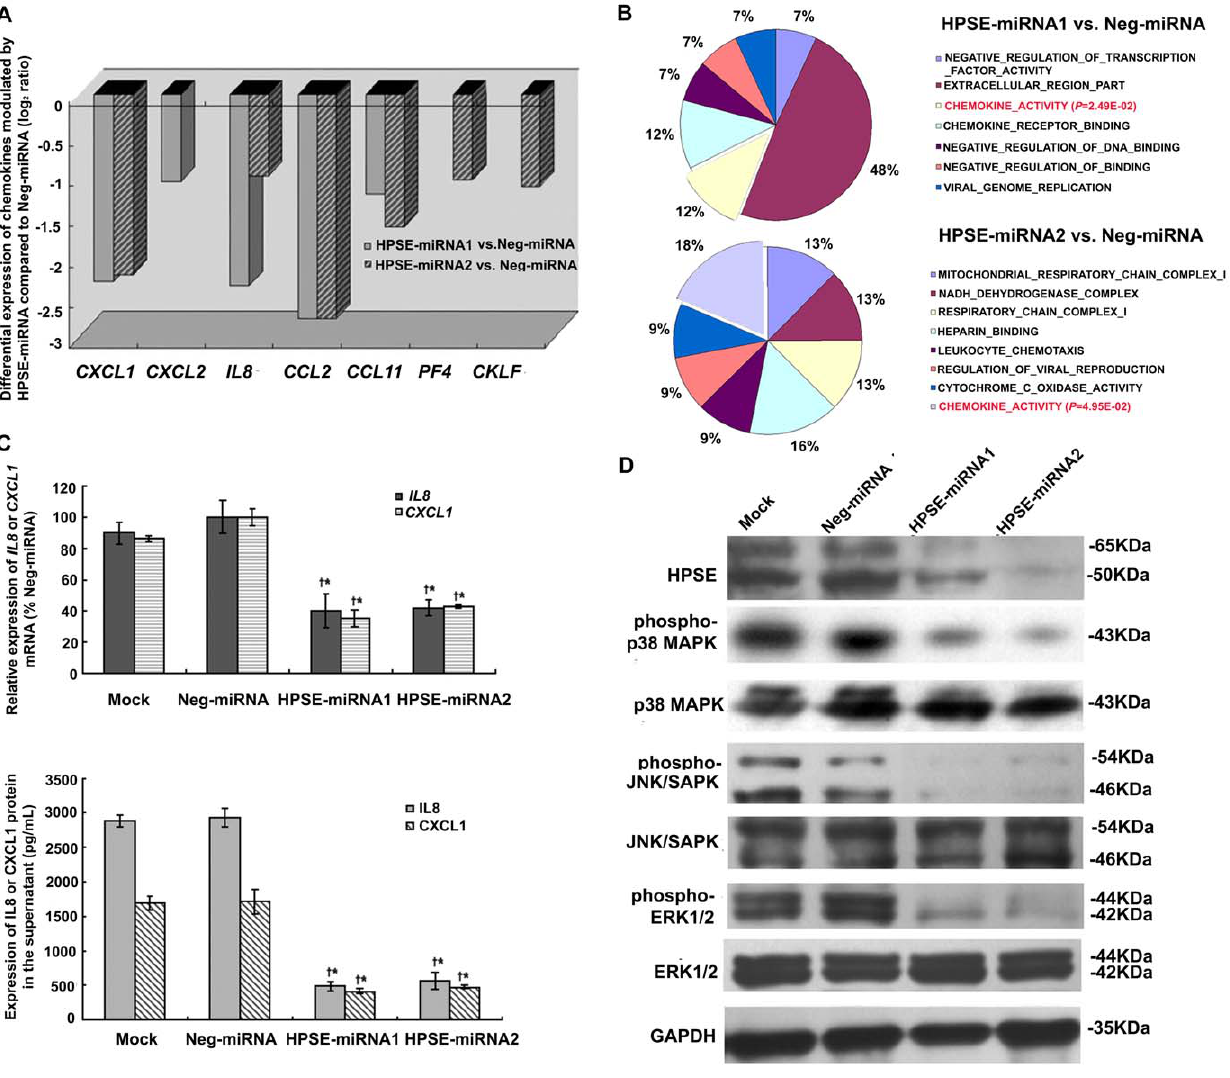
Figure 3. HPSE miRNAs inhibited expression of IL8 and CXCL1 and its probable mechanism. (A) Differentially expressed chemokine genes in the HPSE-miRNA1 and HPSE-miRNA2 groups compared to the Neg-miRNA group (log 2 ratio $ 1 or log 2 ratio #2 1 and P , 0.05). (B) Pathways including chemokines activity modulated by HPSE-miRNA1 or HPSE-miRNA2 were confirmed to be significant by gene-set enrichment analysis ( P , 0.05). (C) Both the mRNA and protein levels of IL8 and CXCL1 in HPSE miRNA transfected A375 cells were decreased compared to either control group. ( { P , 0.001, compared with the parental cells; * P , 0.001, compared with the Neg-miRNA transfected cells). (D) Attenuation of the HPSE- induced phosphorylation of MAPKs by HPSE miRNA. Phosphorylation of MAPK p38 (second and third panel), JNK/SAPK (fourth and fifth panel), and ERK1/2 (sixth and seventh panel) was monitored by western blotting.